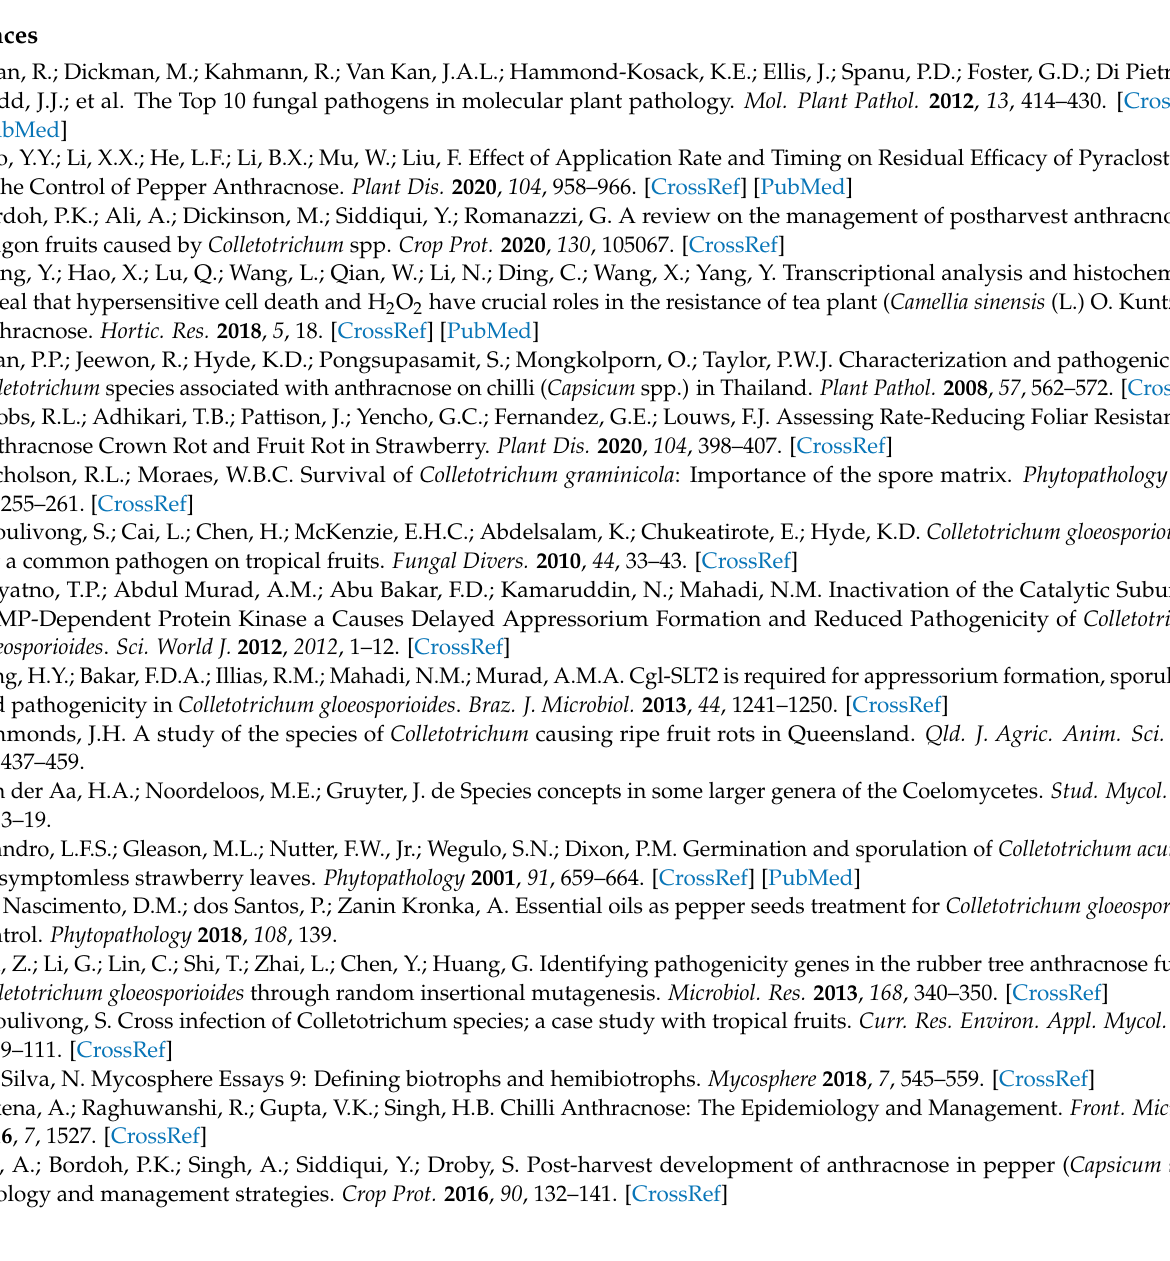
CaPDS , Table S4: Primer pairs for transformation of CaChiIII2 , Table S5: Primer pairs for subcellular localization of CaChiIII2